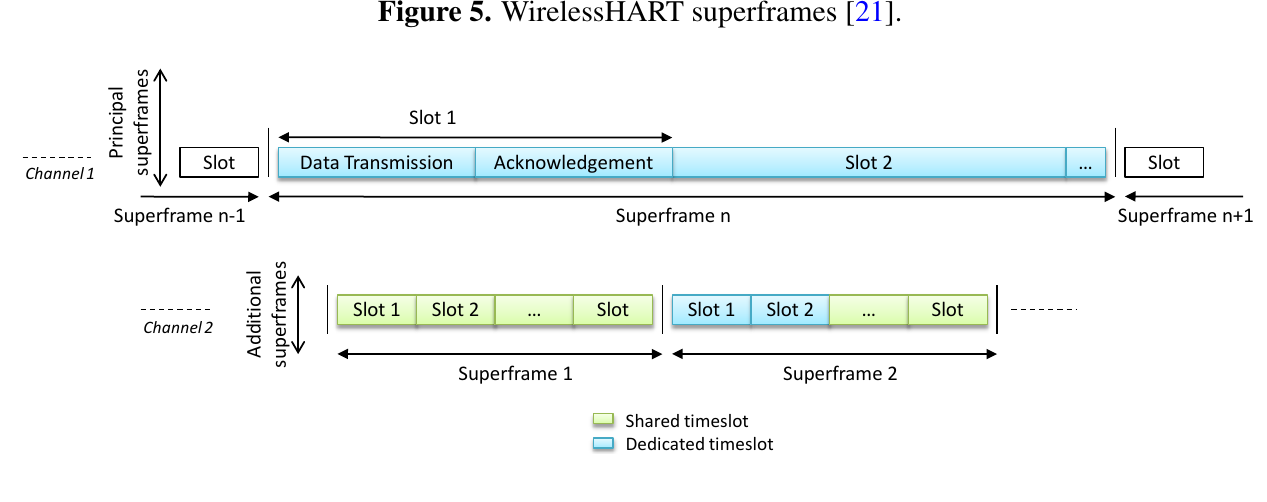
Figure 5. WirelessHART superframes